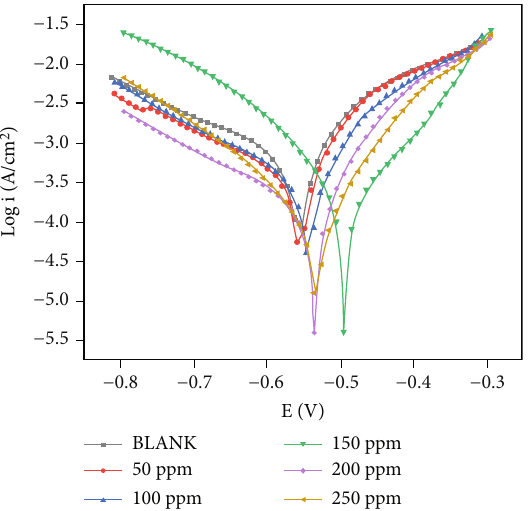
Figure 6: Tafel plot for MS obtained with the absence and presence of 50-250ppm of 3-NA 1 N